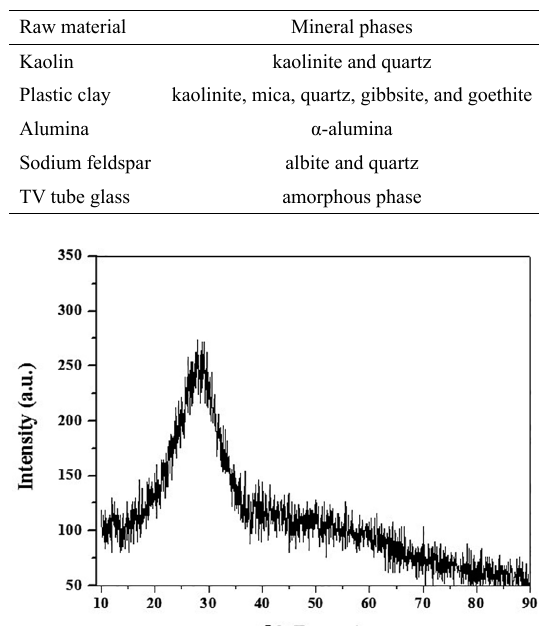
Table 2. Mineral phases identified in the raw materials.